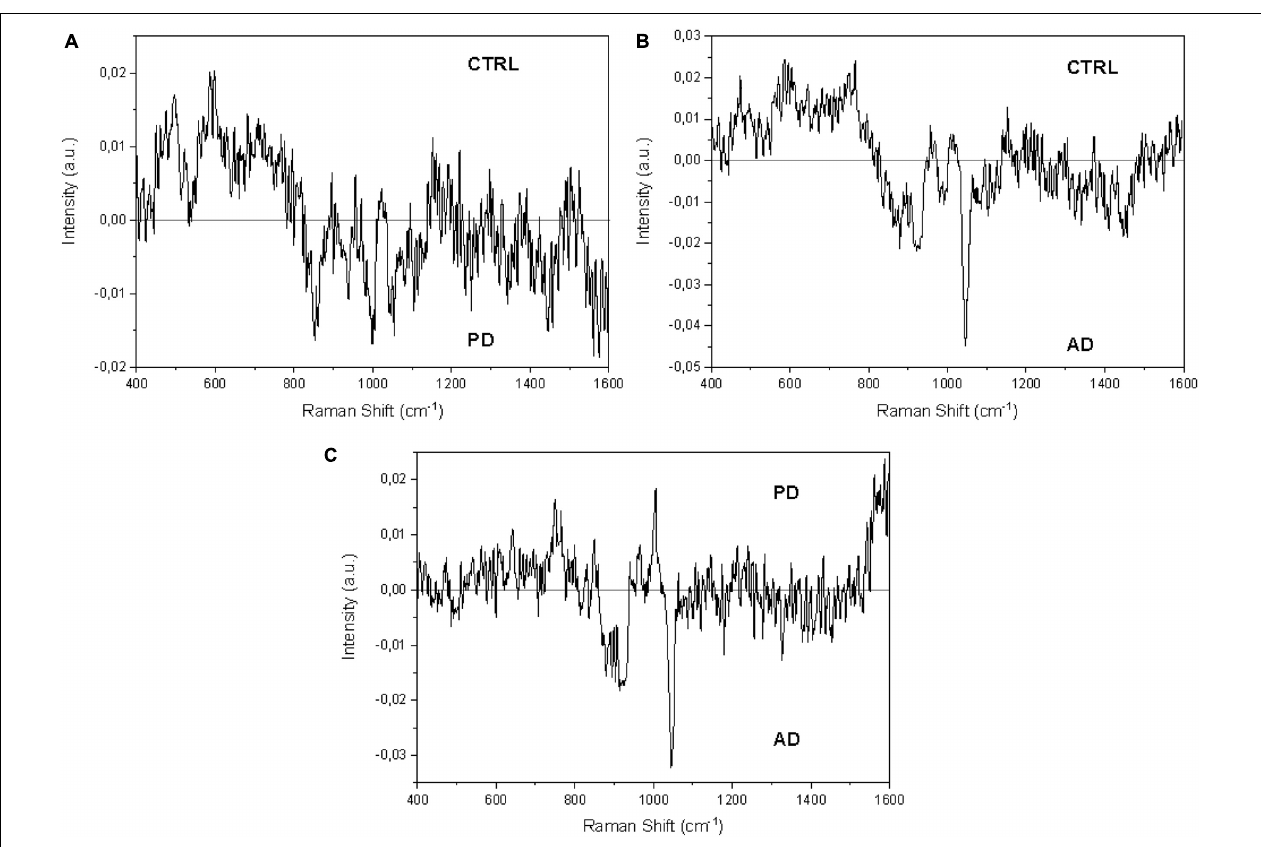
Figure 3 | Subtraction Raman spectra of (A) the average CTRL versus the average PD signals, (B) the average CTRL versus the average AD signals, and (C) the average PD versus the average AD signals.